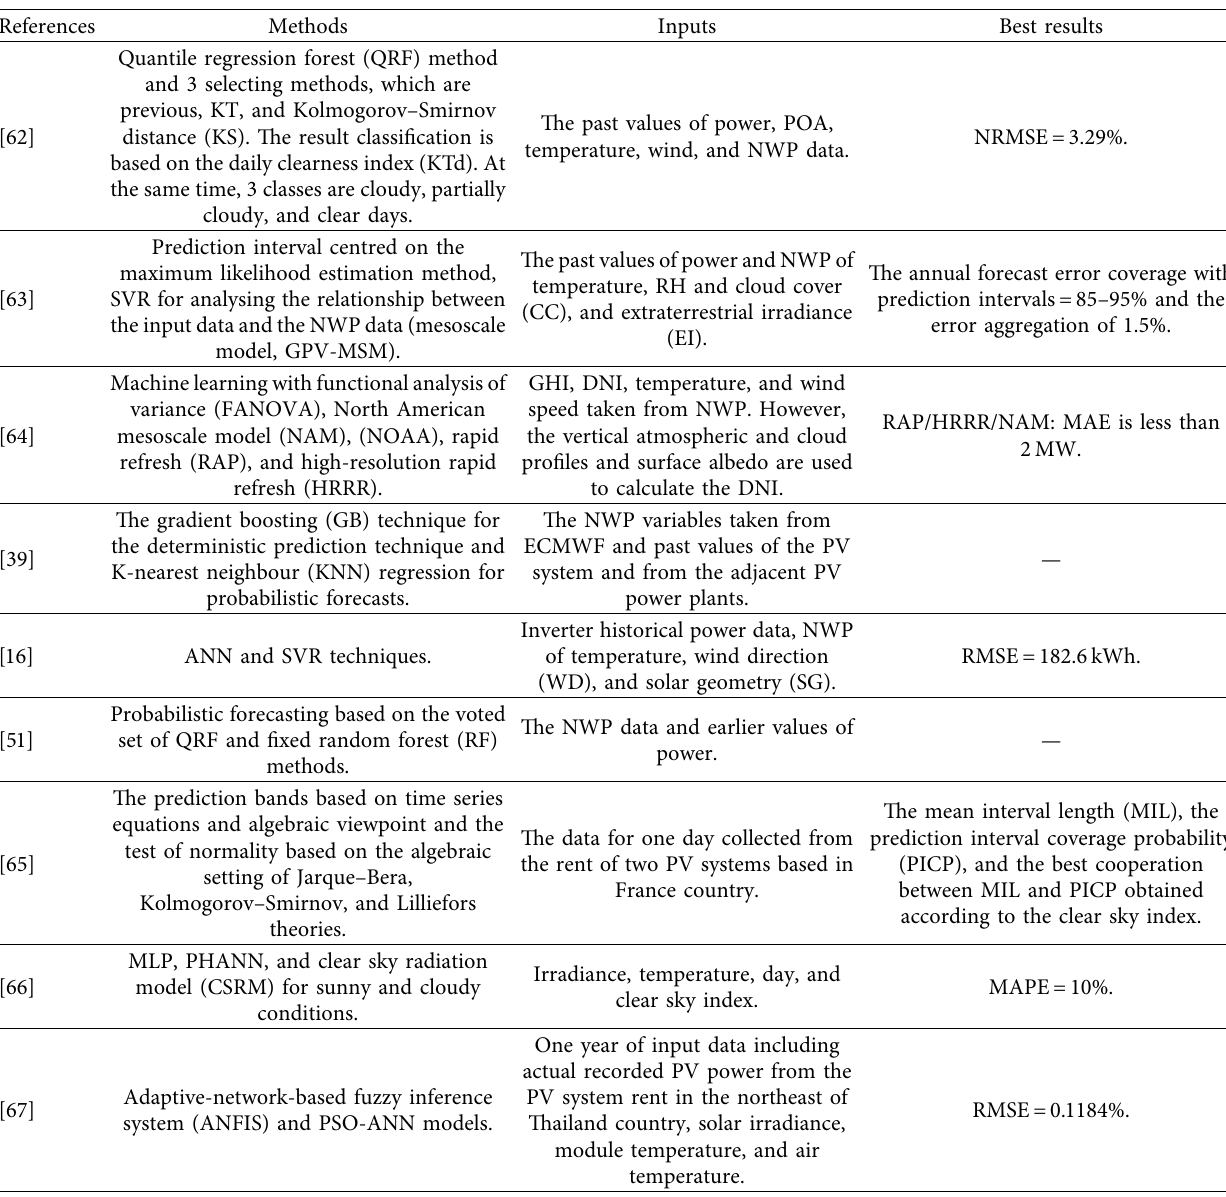
Table 4: Summary of the literature review in the short-term time